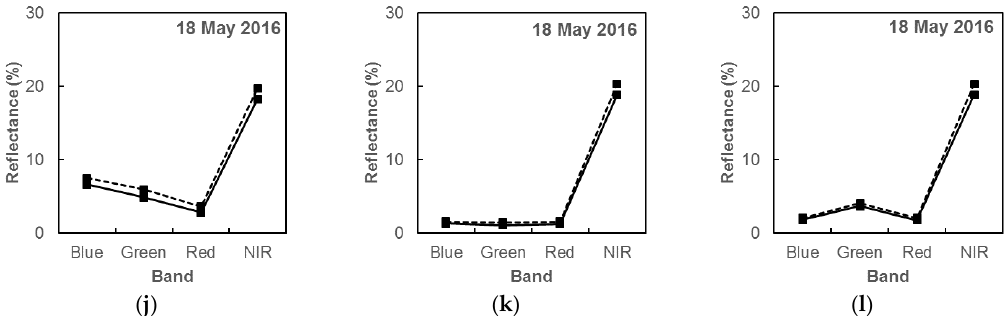
Figure 4. Reflectance of ECF pixels at two different altitudes (601 m a.s.l. and 1289 m a.s.l.) before atmospheric correction ( a , d , g , j ), after elevation-dependent DOS ( b , e , h , k ), and after the application of additional offset ( c , f , i , l ) for Landsat OLI sub-images dated 26 May 2013, 14 August 2013, 4 August 2015, and 18 May 2016, respectively.